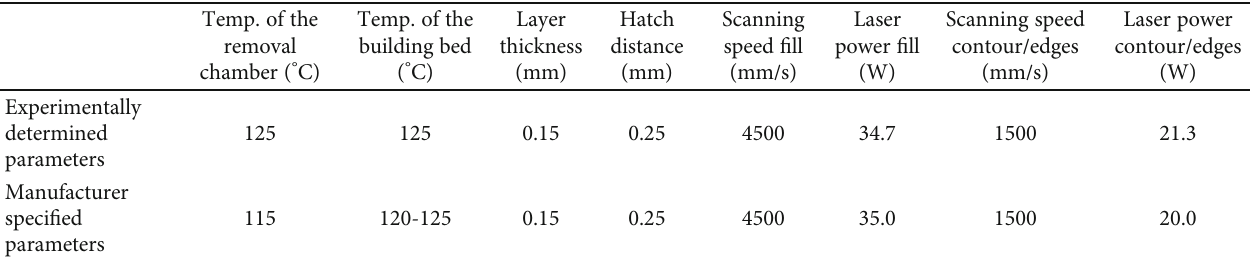
Figure 7: Comparison of the ultimate tensile strength for the printed specimen. Table 7: Experimentally determined and manufacturer ’ s process parameters for Laser PP CP 60, based on mechanical properties of built tensile test